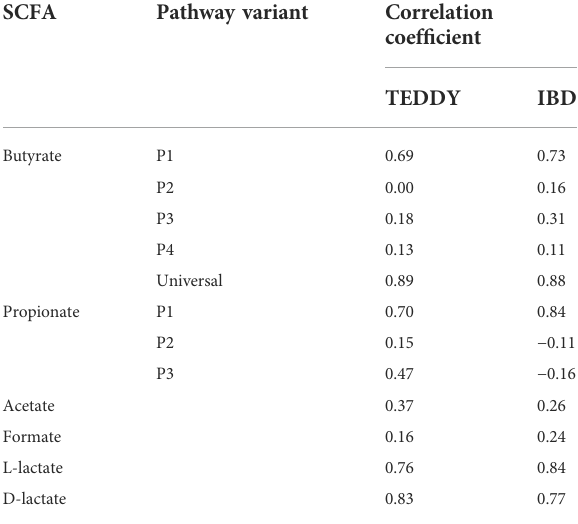
TABLE 3 Correlation coef fi cients between Community Phenotype Indices(CPI)andSCFApathwayabundancesintheTEDDYandIBD WGS datasets.